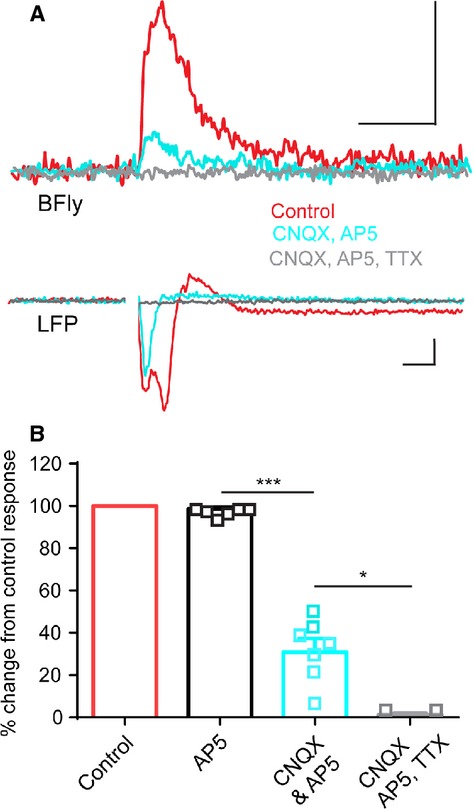
Electrical stimulation-induced Butterfly VSFP2.1 signals from the layer 2/3 population are predominantly synaptic but also contain a fast action potential-mediated component.(A) High stimulation voltage (90 V) -induced Butterfly response integrated over a large region of L2/3 (16× objective, 300 μm × 300 μm, average of five sweeps, widefield imaging) showing an initial fast component followed by a slower, longer lasting component (scale bars 0.5% ΔR/R0, 500 ms). The LFP exhibits a fast antidromic action potential and slower synaptic response (scale bars 0.1 mV, 5 ms), stimulus artifacts are removed. (B) pharmacological treatment with the excitatory glutamatergic synaptic blockers CNQX and APV reduces the Butterfly signal, leaving a TTX sensitive component remaining. Error bars are mean ± SEM and *** and * represent P < 0.001 and P < 0.05 (one-way ANOVA).